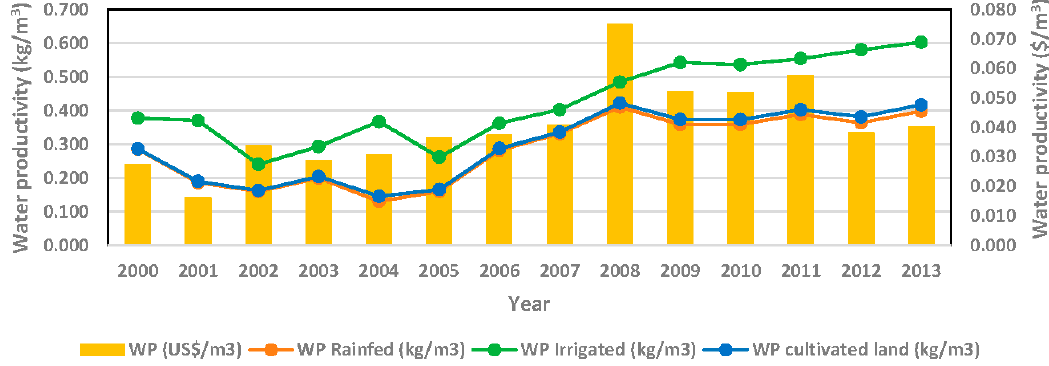
Figure 3. Comparison in the trends of physical and economic water productivity over time.